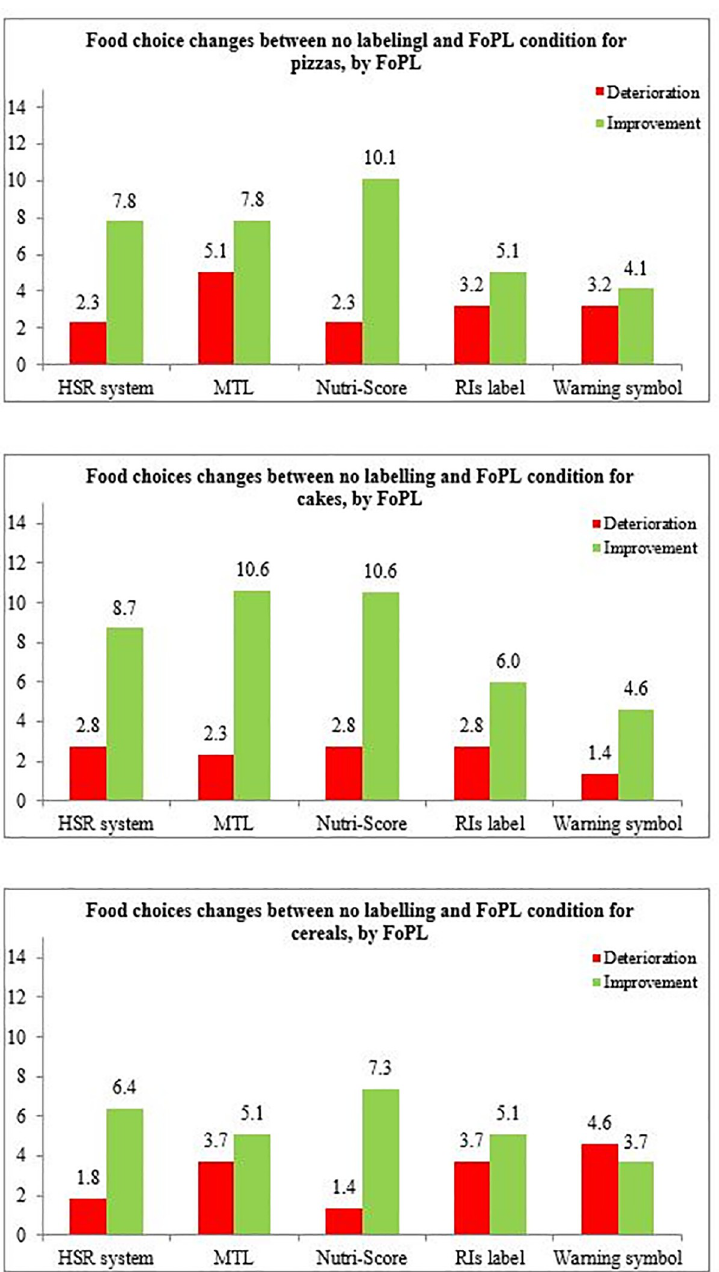
Fig 3. Percentages of deterioration and improvement of the nutritional quality of food choices, by FoPL type and food category. Associations between FoPL type and food choices are displayed in Table 2 . The Nutri-Score was the only FoPL to demonstrate a significant effect on the improvement of the nutritional quality of food choices compared to the RIs label. This occurred overall (OR = 1.83[1.17–2.86], p-value = 0.008) and among pizzas (OR = 1.90[1.01– 3.57], p-value =